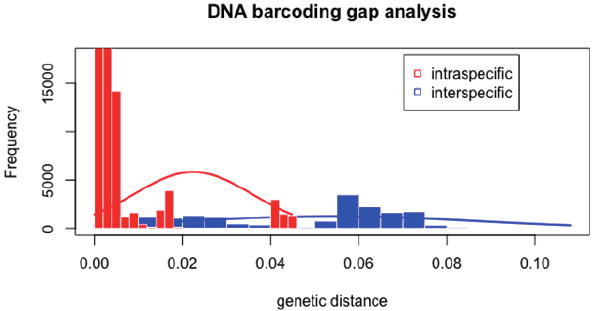
Figure 14. Barcode gap analysis of ITS sequences revealing both intra- as well as inter-specific sequence difference in Avicennia spe- cies studied.